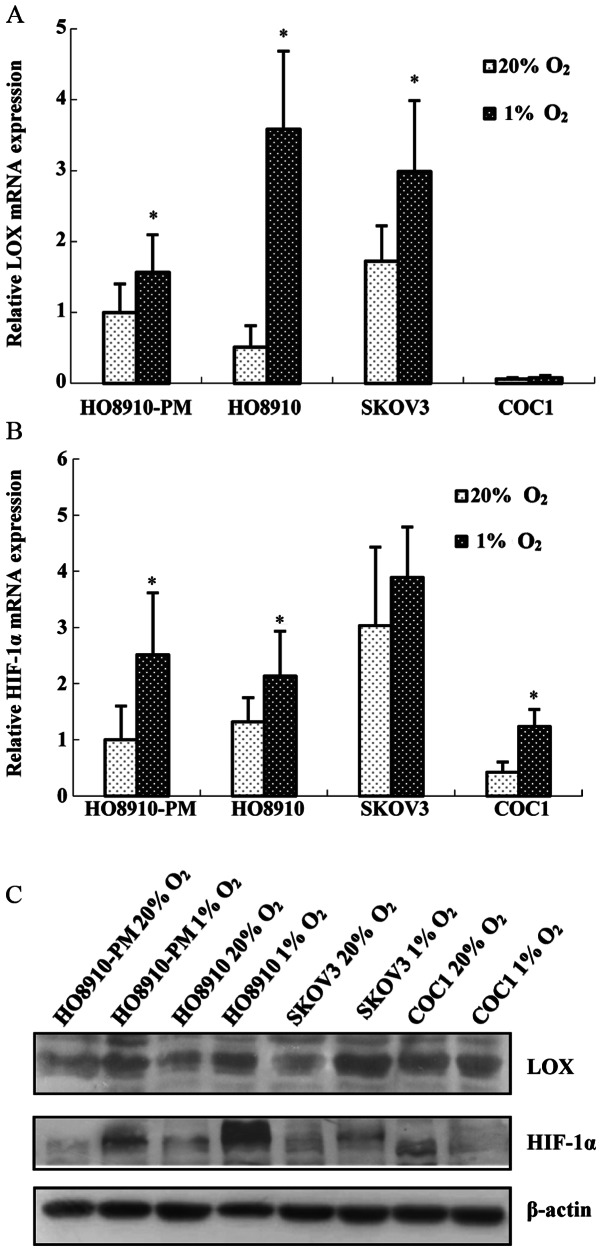
Hypoxia increases expression of LOX and HIF-1α in ovarian cancer cell lines. HO8910-PM, HO8910, SKOV3 and COC1 ovarian cancer cells were exposed to normoxia (20% O2) or hypoxia (1% O2) for 24 h. (A) Quantitative RT-PCR (Q-PCR) of LOX mRNA expression. (B) Q-PCR of HIF-1α mRNA expression; GAPDH was used as a reference gene (n=3 replicates per group); *P<0.05 vs. normoxic control cells. (C) Western blot analysis of LOX and HIF-1α protein expression; β-actin was used as a loading control.